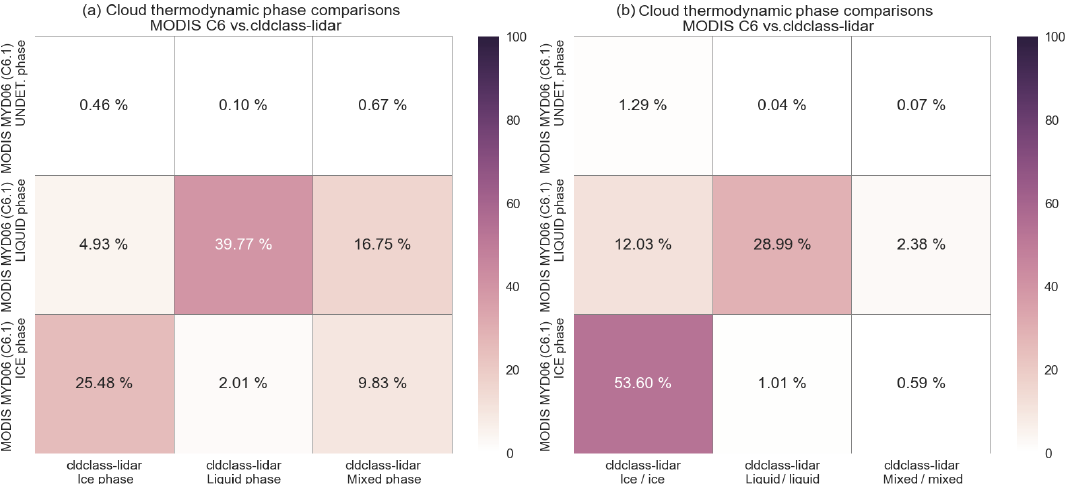
Figure 5. MYD06 C6.1 cloud thermodynamic phase compared to 2B-CLDCLASS-lidar cloud phase: (a) monolayer clouds (about 63% of the data set) and (b) multilayer clouds having the same phase (about 10% of the co-located data set). Here, monolayer and multilayer clouds are defined by